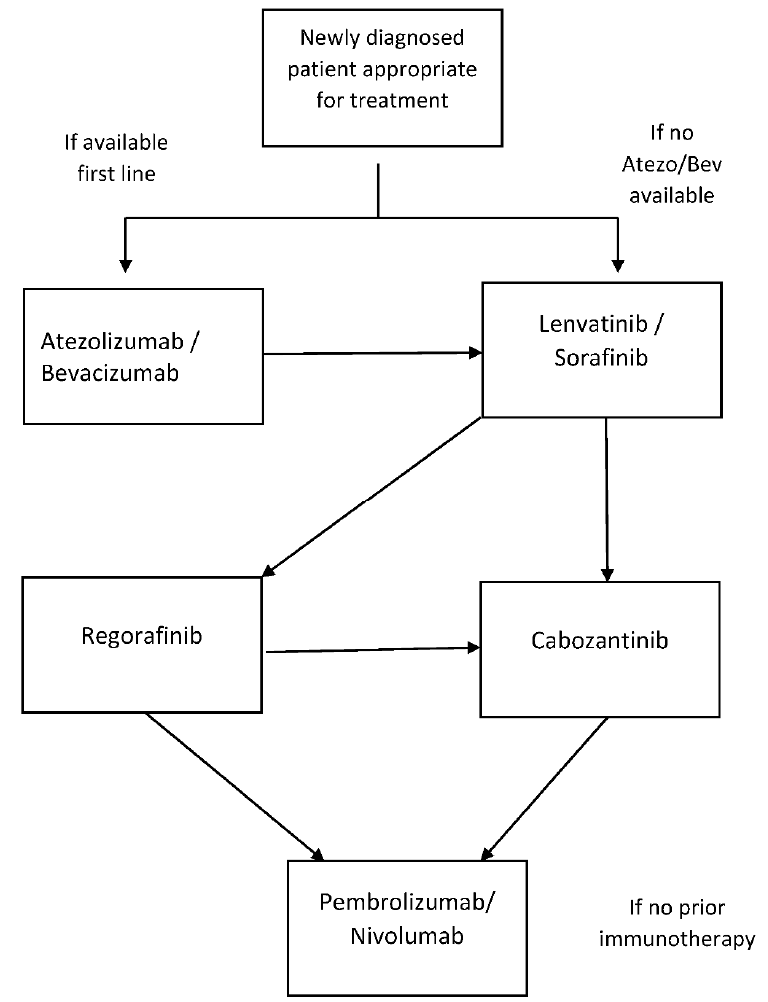
Figure 2. Systemic therapy flow chart.